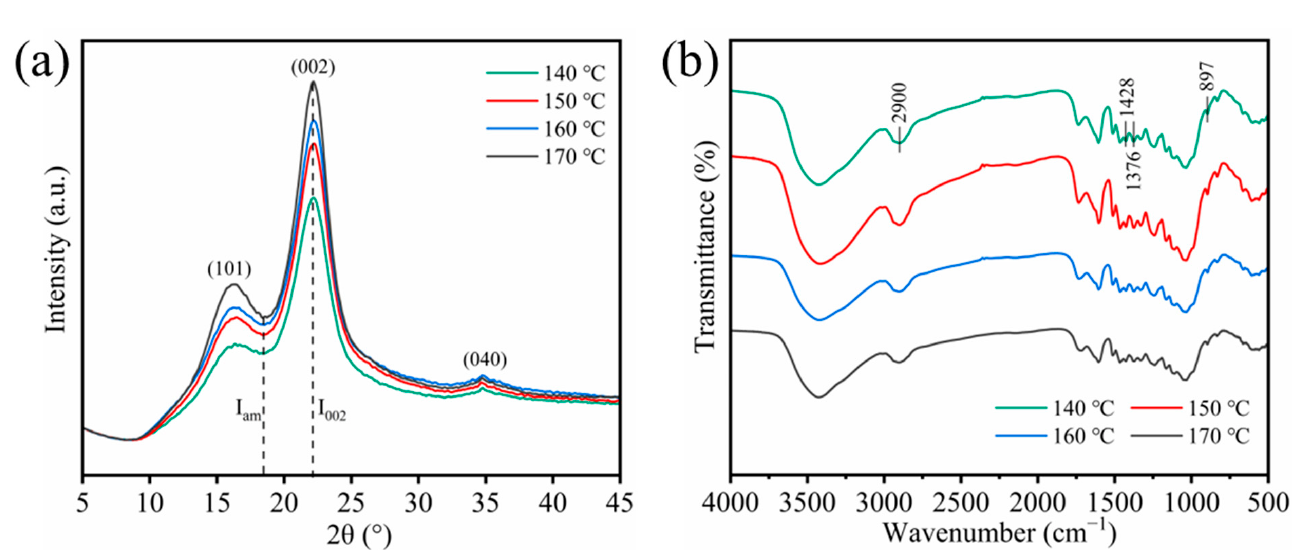
Figure 7. ( a ) The XRD patterns of bamboo scrimber slices. ( b ) FT-IR spectra of bamboo scrimber powder.